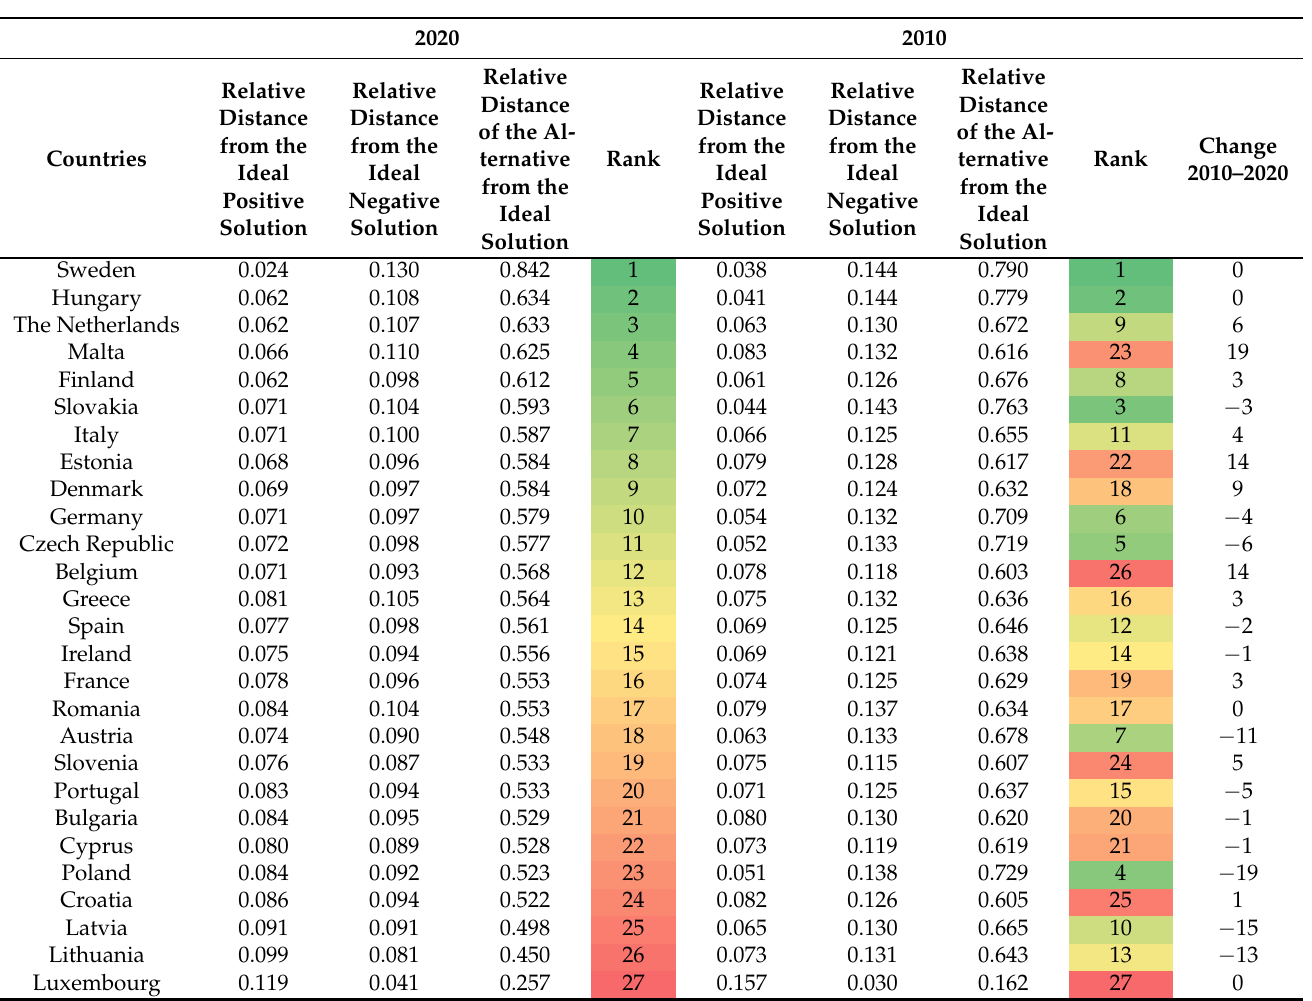
Table 2. Transport sector sustainability of the EU countries and achievements made in the last